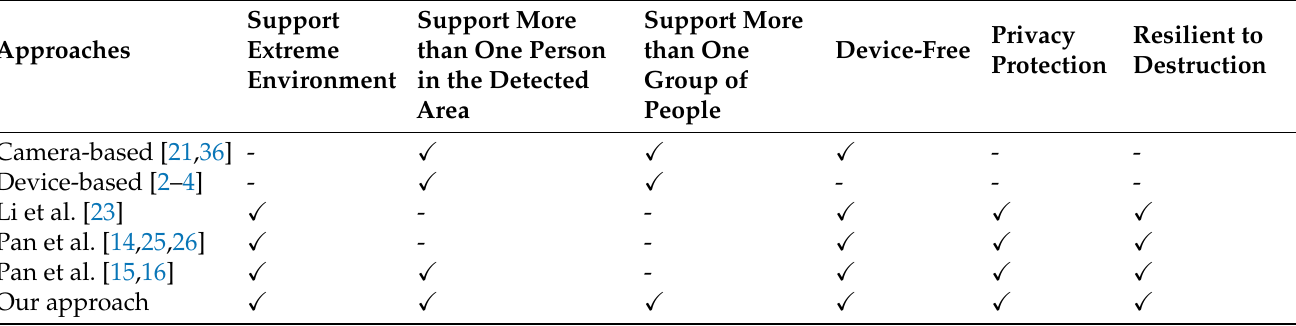
Table 2. Capabilities of different